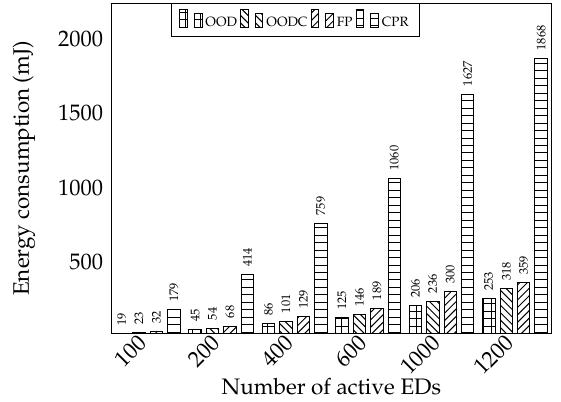
Figure 10. Measurement of energy consumption.